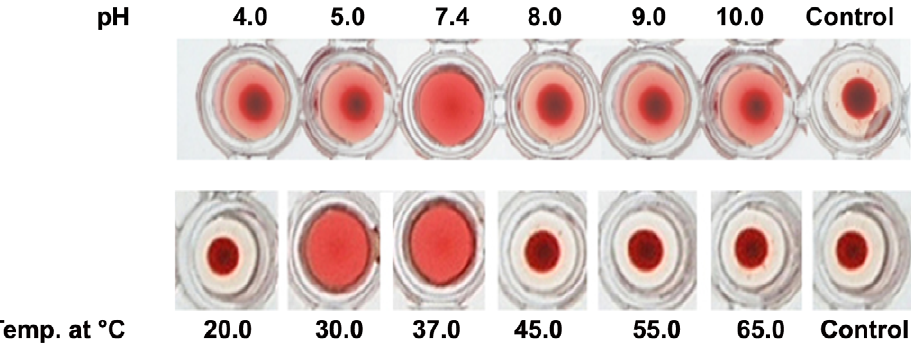
Figure 4. Hemagglutination activity of 10 m g of elution peak II protein (AMFL)/well at different pH and temperature. Hemagglutinating activity of Peak II protein (AMFL) from 60% ammonium sulphate precipitate of Aegle marmelos fruit extract at different pH and temperature. Hemagglutinating activity was found at pH 7.4 and at 30 & 37.0 u C.